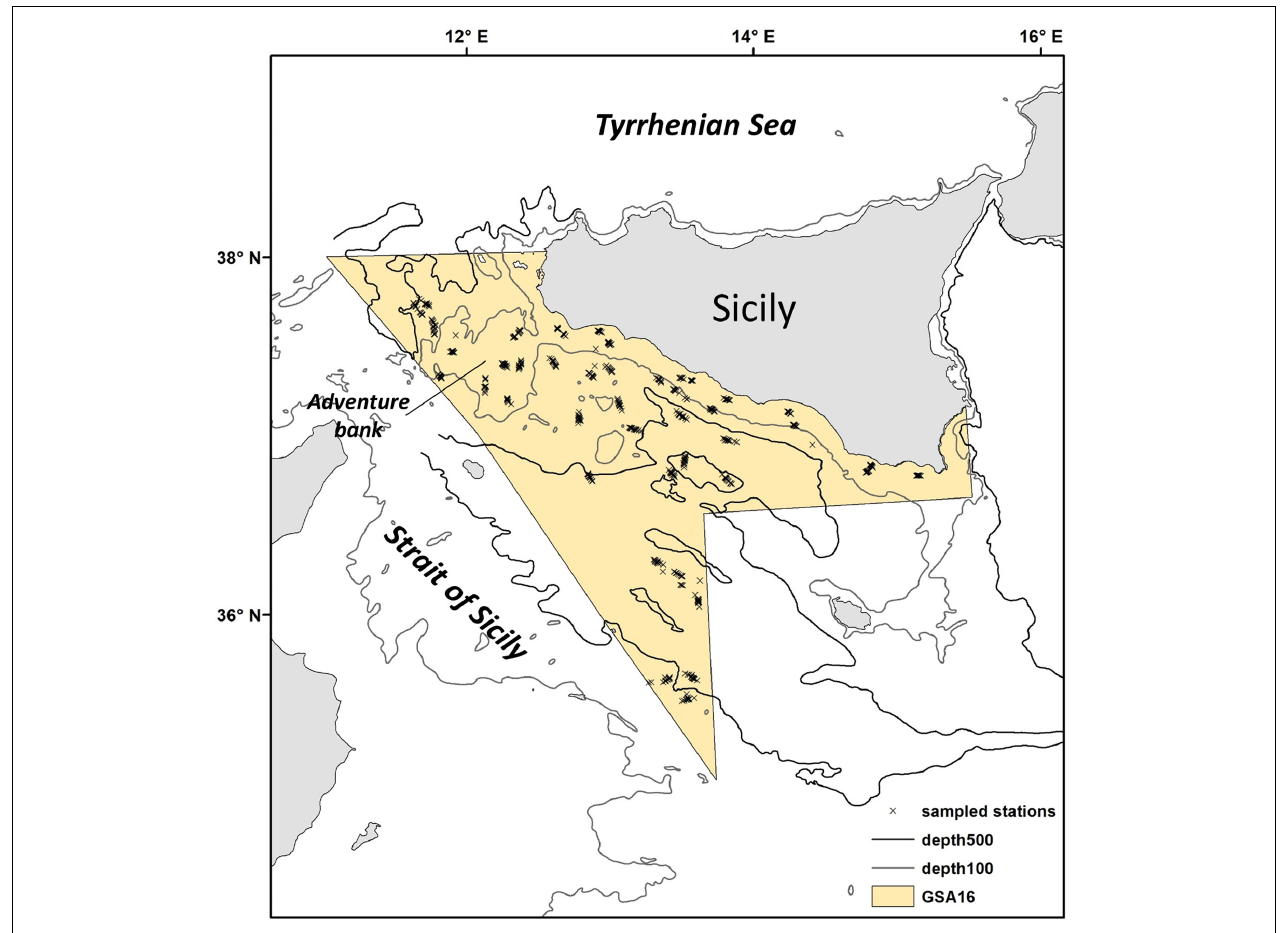
FIGURE 1 | Location of the study region within the Strait of Sicily (Central Mediterranean Sea). This area corresponds to the Geographic Sub Area (GSA) 16. Trawl stations sampled during the MEDITS Survey are indicated with an